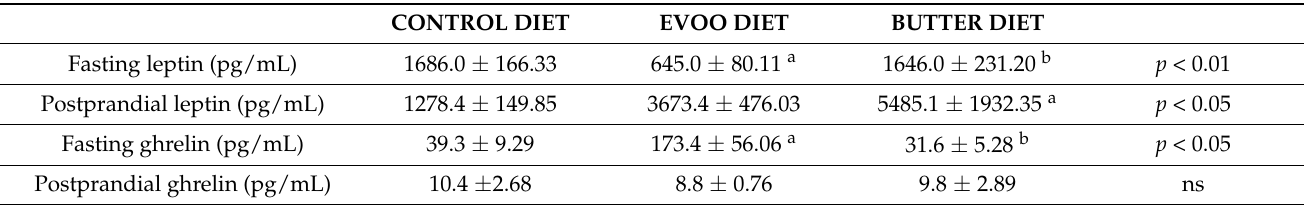
Table 2. Mean values ± SEMs expressed as pg/mL of plasmatic levels of leptin and ghrelin in fasting and postprandial conditions (30 min after food intake) for the three groups of animals (control diet, butter diet, and EVOO diet). a: significant differences between EVOO, butter, and control diets. b: significant differences between EVOO and